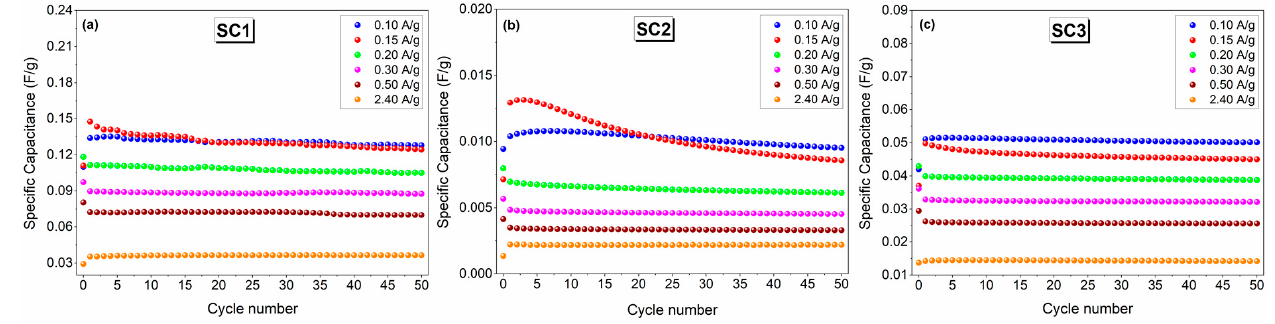
Figure 9. Comparison of the cycling performance of the symmetric and asymmetric all-in-one SCs at a current density of 0.15 A.g − 1 : ( a ) SC1, ( b ) SC2, and ( c ) SC3. a current density of 0.15 A.g − 1 : ( a ) SC1, ( b ) SC2, and ( c )